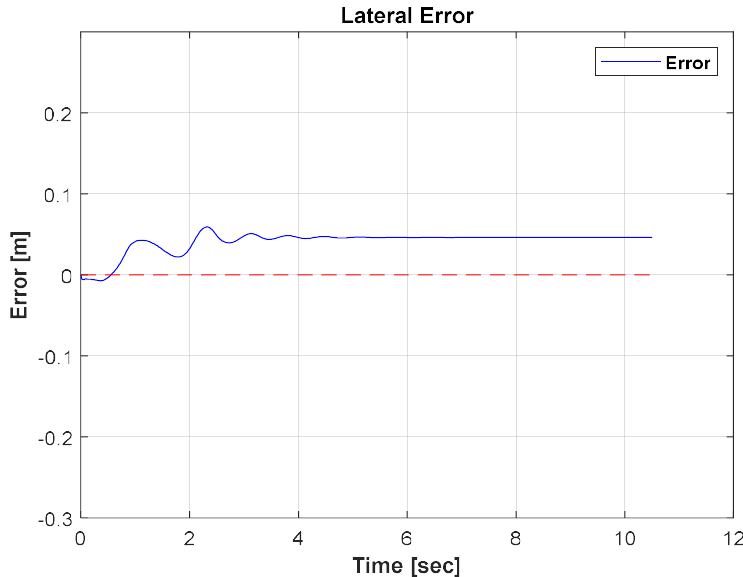
Figure 20. Lateral position error during the drift maneuver.